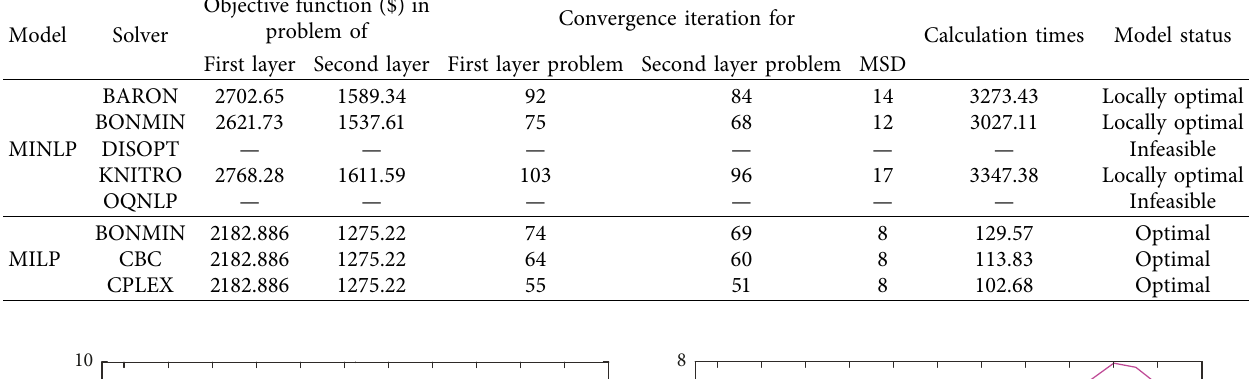
Table 4: Convergence results of the proposed problem based on MSD obtained by different solvers. Model